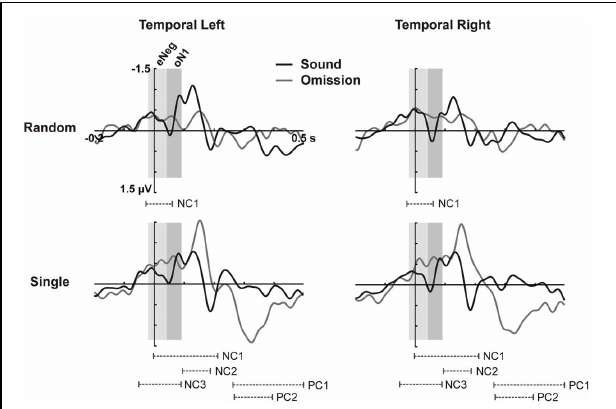
FIGURE 2 | Cluster analysis on temporal ROIs. ERPs for the temporal left (left column) and temporal right (right column) ROIs (averaged over electrodes in the ROI) are plotted for sounds and omissions in the random sound (top row) and the single sound (bottom row) condition. Both sound and omission responses are motor-corrected via subtraction of the no-sound motor control waveform. Temporal clusters in which omission responses differed significantly from the motor control are indicated under the waveforms for each sound condition (NC: Negative cluster, PC: Positive cluster). Time-windows defined on the basis of the cluster analysis for the eNeg ( − 20 to 40ms) and oN1 (42 to 92ms) components are indicated with gray